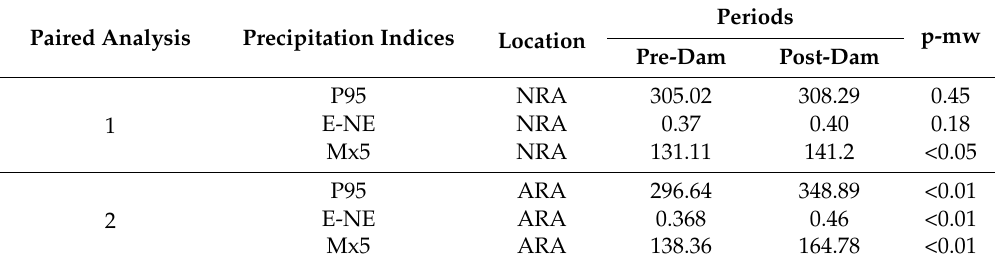
Table 6. Statistical difference tests for the mean in the extreme rainfall indices (P95/mm, E–NE (fraction) and Mx5/mm) from weather stations for the different periods. (ARA: reservoir area and the NRA: near reservoir area).